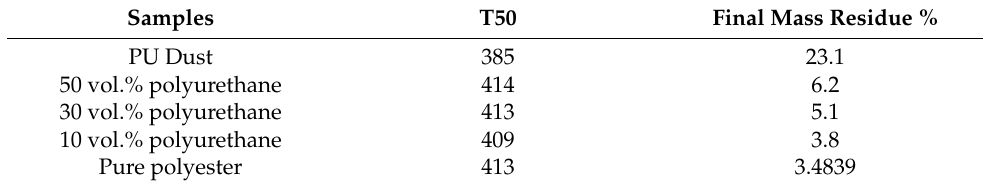
Figure 8. Thermograms of UPR, PUD and UPR-PUD composites: ( a ) TGA and ( b ) DTG. Table 1. TGA results of UPR-PUD